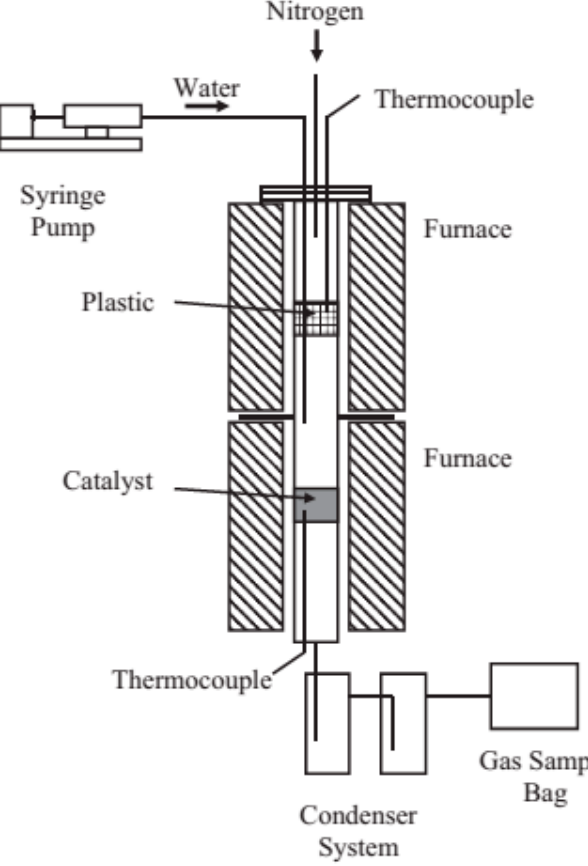
Figure 10. Sketch map of the reforming installation (reprinted with permission from Ref. [70], copyright 2015 Elsevier).